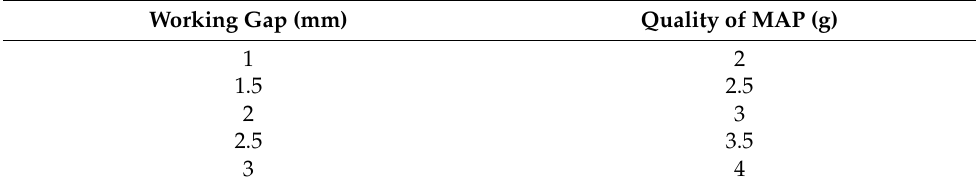
Table 4. Weight of MAP applied in different working